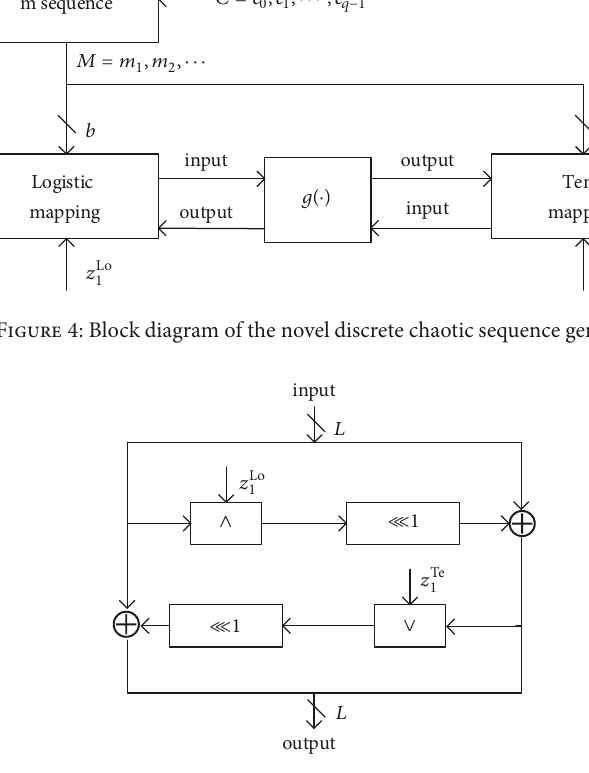
Figure 5: The structure schematic diagram of the function 𝑔(⋅)